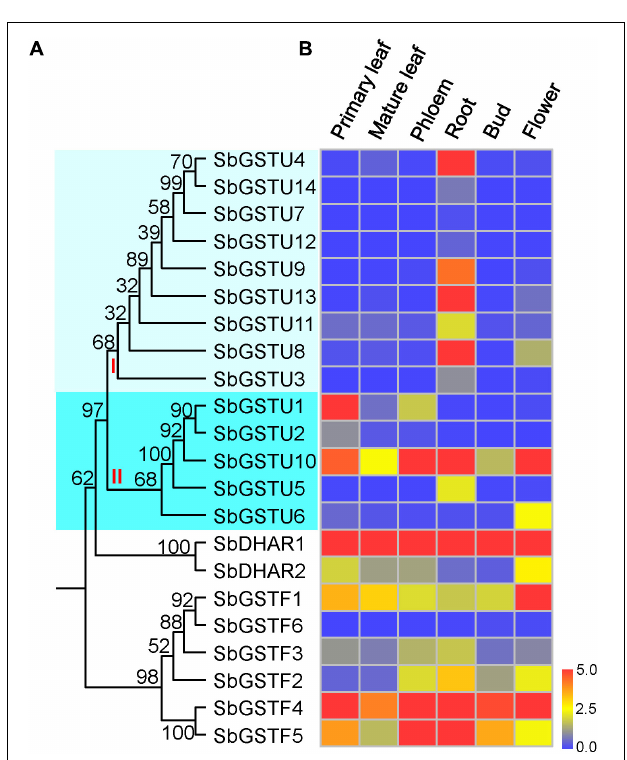
FIGURE 4 | Phylogenetic tree of Salix GSTs (A) and their expression patterns (B). In (A) , the phylogenetic tree is from Figure 1 . Salix tau GSTs are grouped into two clades (clade I and II). The relative expression levels of GST genes by real-time PCR are shown in (B) . Color scale indicates normalized expression level [2ˆ( − Delta CT)]. The values of relative gene expression level greater than five are represented by the color scale of five. The relative gene expression levels from low to high are represented with color scale from blue to